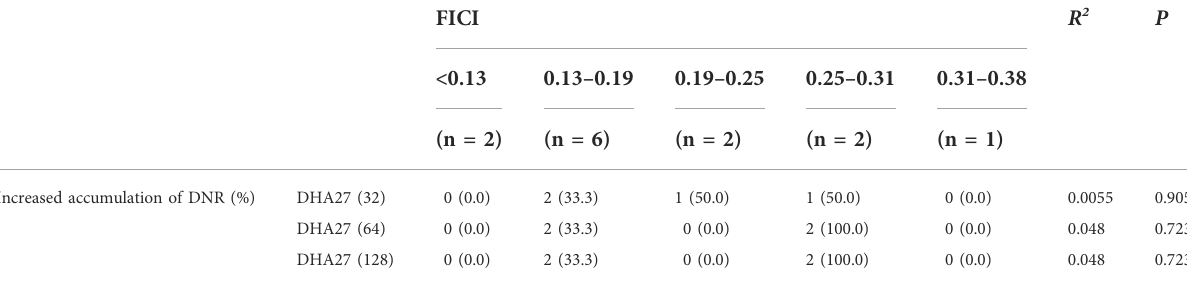
Increased accumulation of DNR (%)